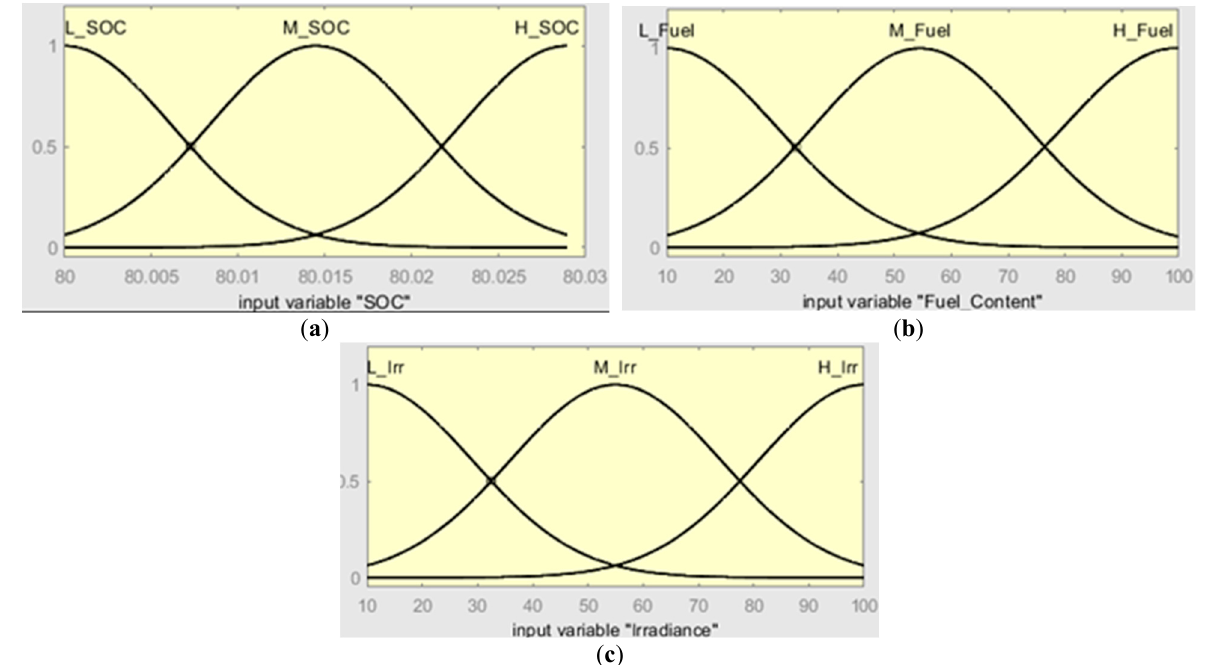
Figure 31. Membership function for the variable ( a ) SOC, ( b ) fuel content, and ( c ) irradiance, re- specttively.